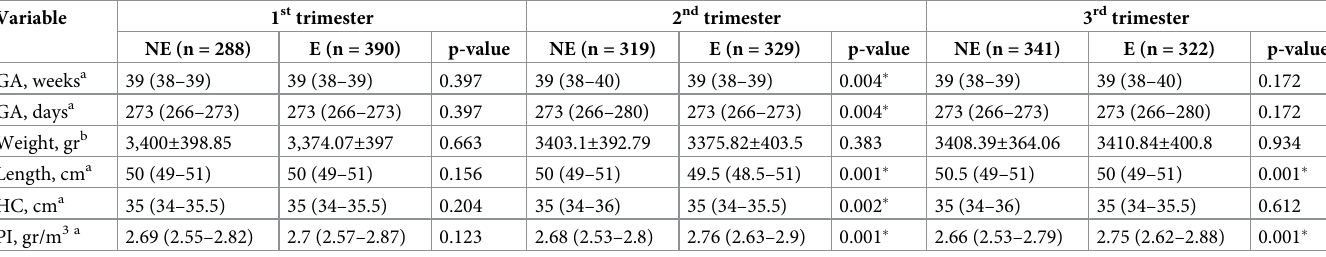
Table 2. Perinatal outcomes of males according to trimester of exposure to